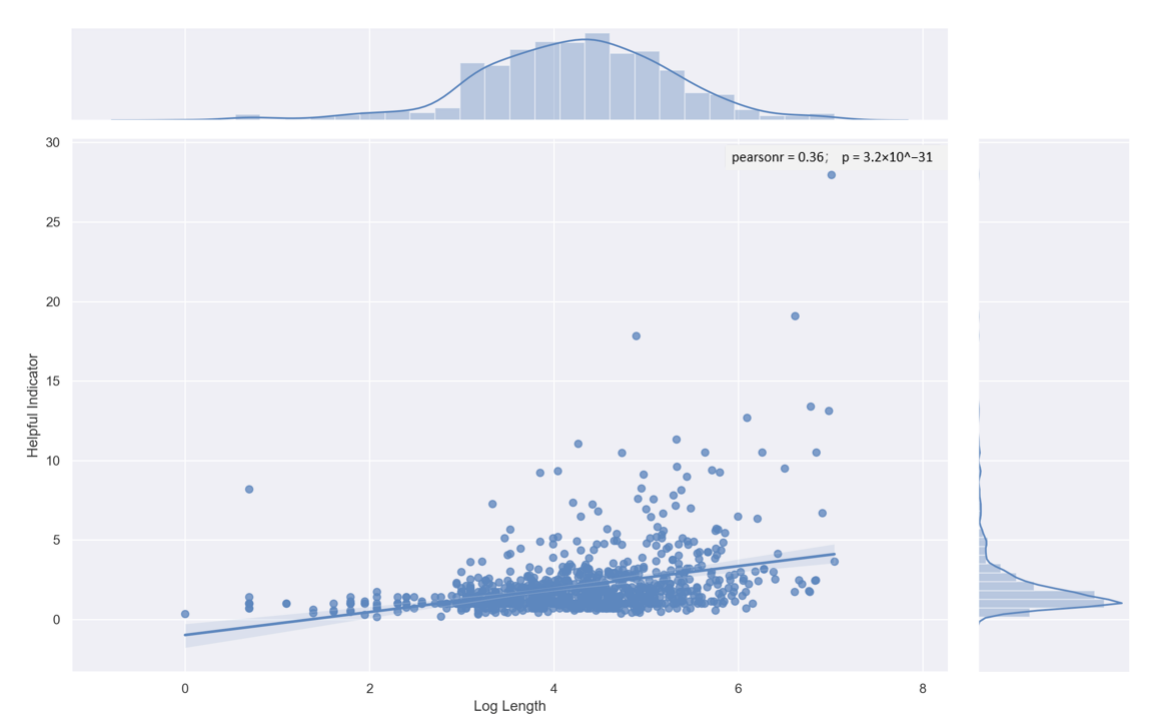
Figure 2. The relationship between comment usefulness and the length of the